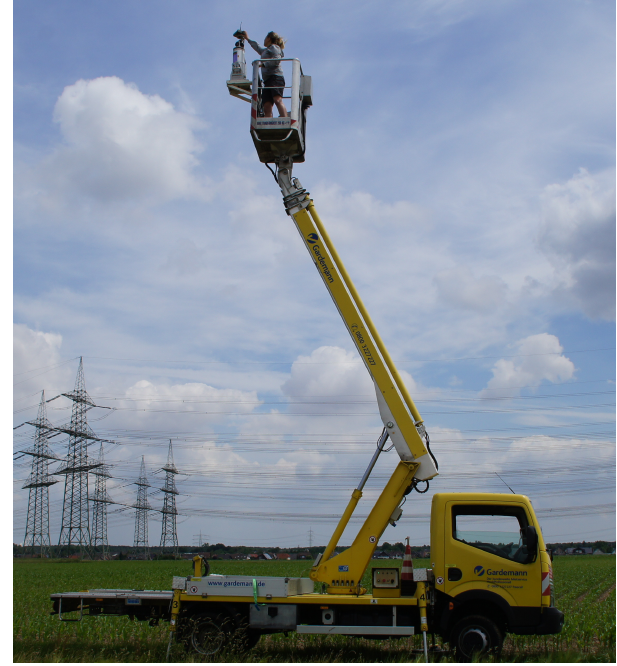
Figure 1. Cherry Picker with Riegl Scanner next to the maize field, date: June 13, 2014.